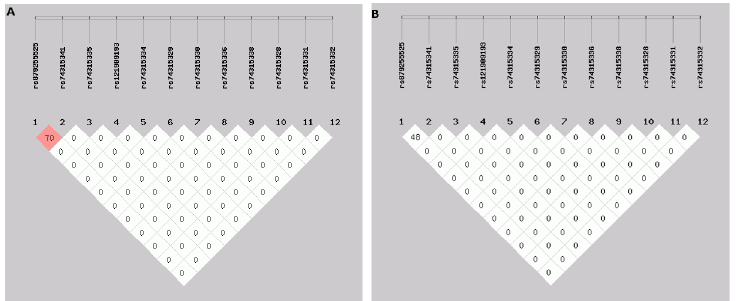
Fig 1. (a,b). Location and map of LDofSNPs onchromosome 1. The SNP numbers are represented at the top of the haploview. The pair-wise LD coefficient (r 2 ) is presented at the top, and LD (cid:3) =